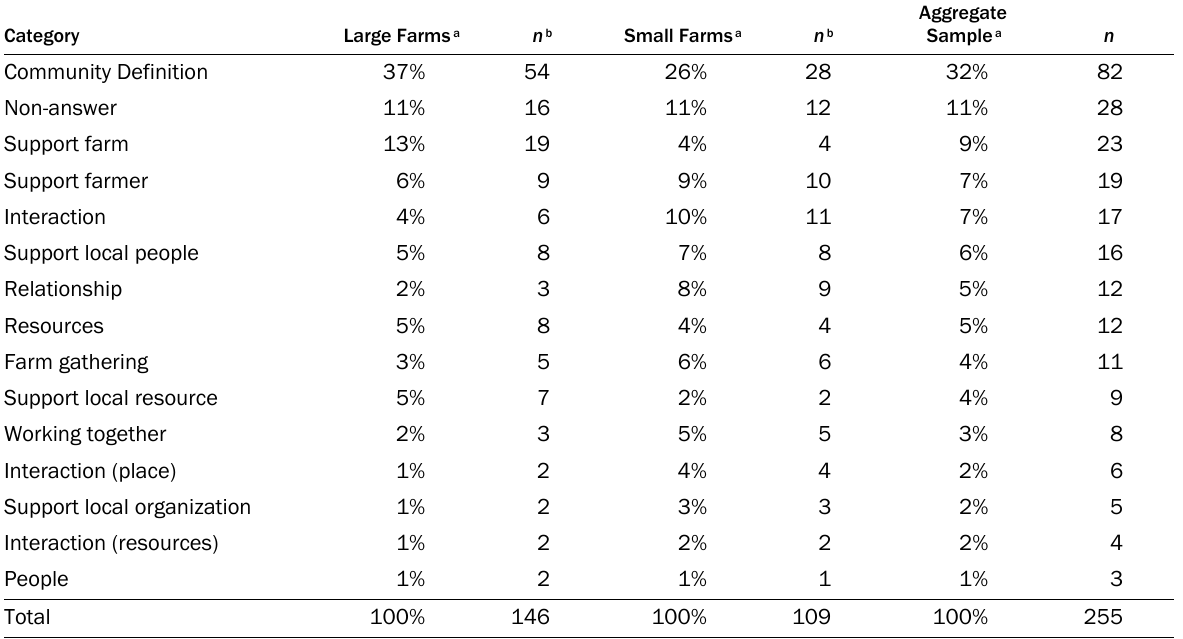
Table 4. Responses to the Question, “What does the community in CSA mean to